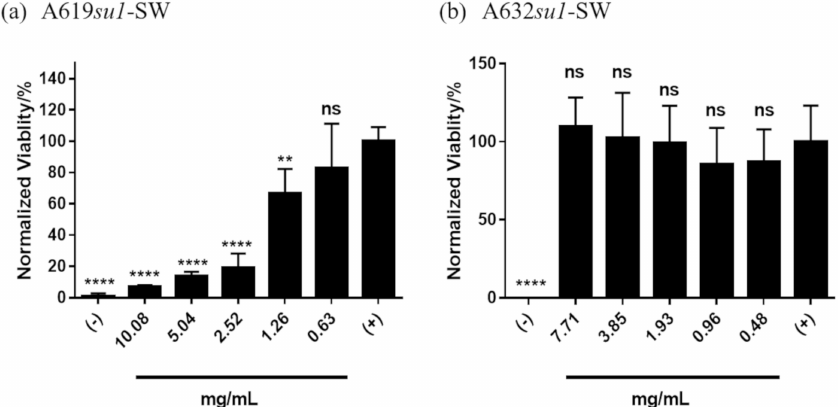
Figure 2. Cytotoxicity of phytoglycogen extracts from two di ff erent plant varieties with the su1 -SW mutant. Phytoglycogen was extracted from both plant varieties using ethanol precipitation. Cells were treated with 50 v / v % PBS (positive control) or 50 v / v % DMSO (negative control). Data are presented as mean ± standard deviation ( n = 5). * indicates statistically significant di ff erences compared to the positive control group; “ns” indicates no di ff erence relative to the positive control group at t = 24 h. Statistical significance was calculated using a one-way ANOVA followed by Tukey’s post-hoc. ** p < 0.01 and **** p <